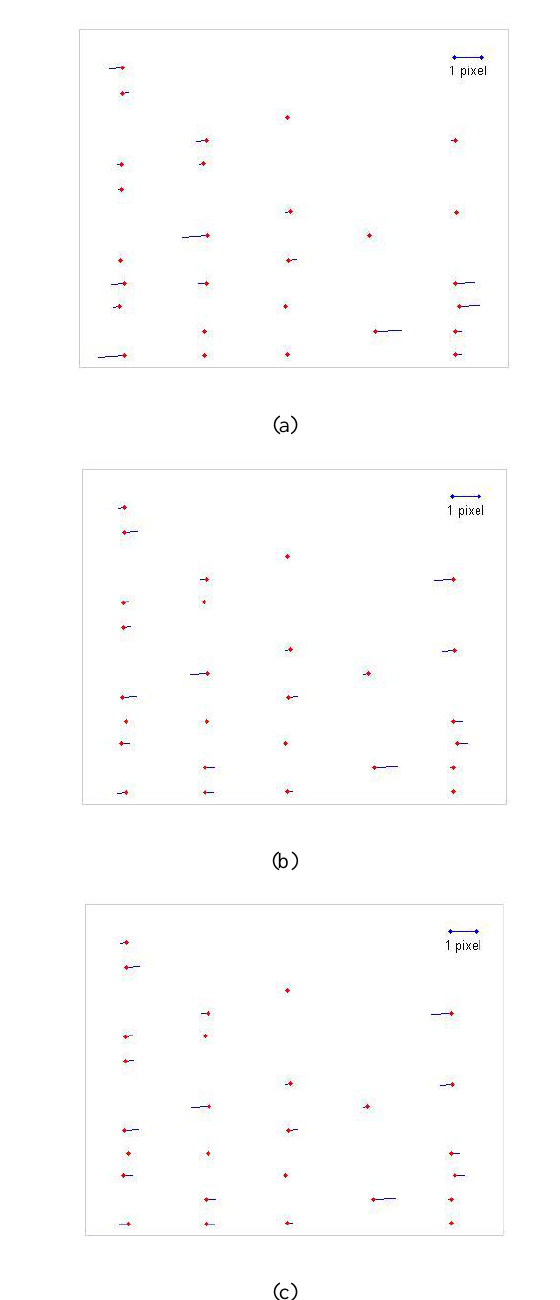
Figure 5. Relative pointing error of WorldView-2 data: (a) before orientation (b) relative bias-compensated method (c) global relative pointing error correction